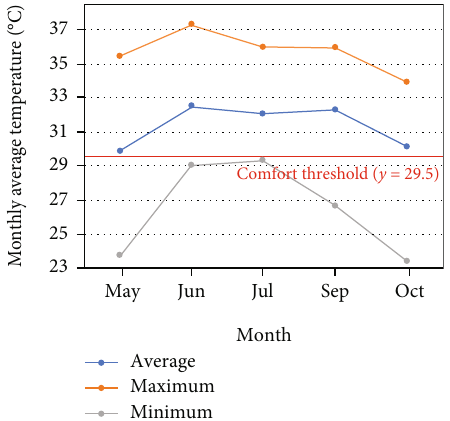
Figure 14: The percentage of time of thermal discomfort (based on PMV >